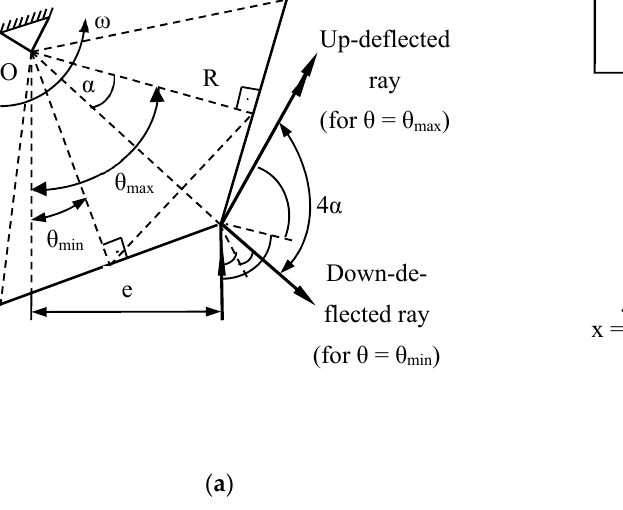
Figure 5. Rotational angles of the PM, θ min and θ max for which the ray reaches the margins of a PM facet: ( a ) The up- and down-deflected rays; ( b ) the two surfaces of the scan angles θ min and θ max for the (most useful) x < 1 and α < π /4 intervals with regard to these two parameters.